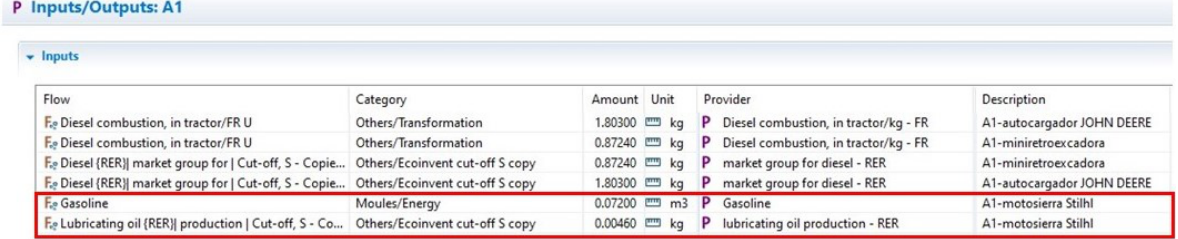
Figure 2. Screenshot of stage A1 in the OpenLCA programme.